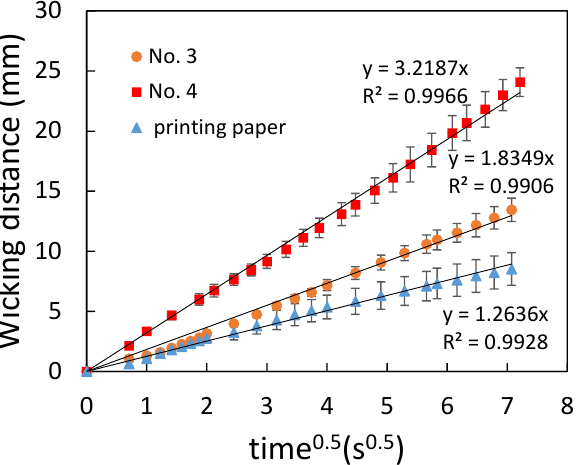
Figure 6. Comparison between the flow behavior of the filter papers and the printing paper.